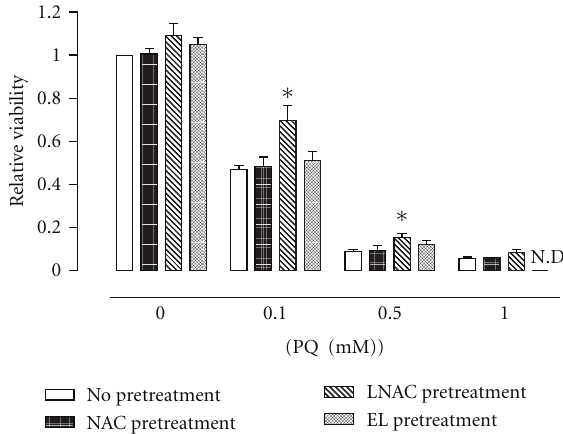
Figure 2: E ff ect of EL, NAC, or L-NAC pretreatment on viability of PQ-challenged cells. The viability of cells pretreated with control media (no pretreatment), or 5.0mM NAC- (NAC Pretreatment), L- NAC- (L-NAC pretreatment) or empty liposome-containing media (EL pretreatment) for 4h prior to 24 h PQ challenge (0, 0.1, 0.5, or 1.0mM) was assessed using the MTT assay. Bars represent mean ± S.E.M. of 3 independent experiments performed in octuplet. ∗ denotes significant di ff erence relative to cells with no pretreatment ( P < . 05); N.D.: not